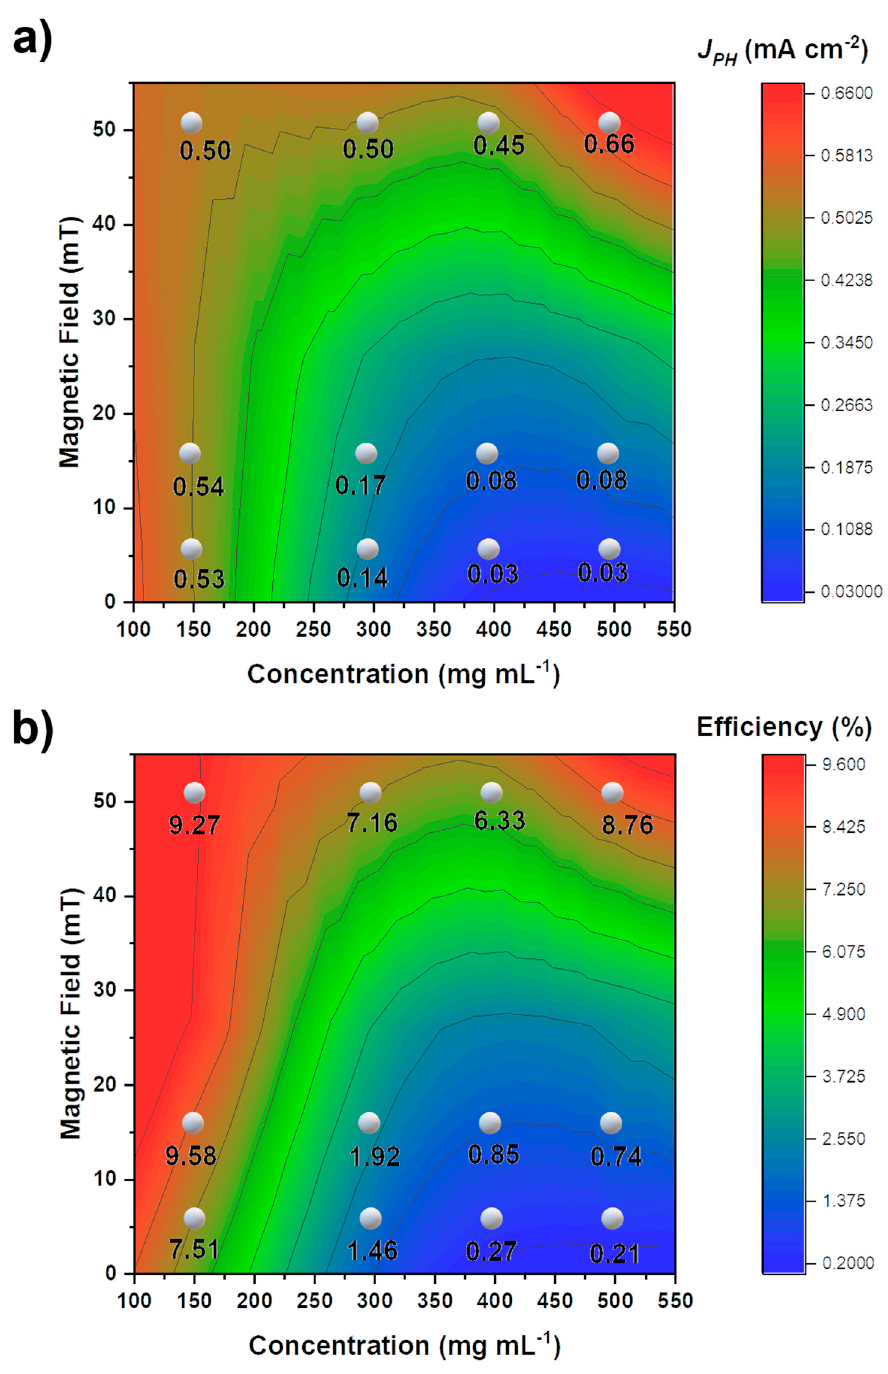
Figure 8. Response of photoelectrochemical measurements for ( a ) front illumination and ( b ) effi- for different magnetic fields and nanoparticle ciency for different magnetic fields and nanoparticle concentrations.